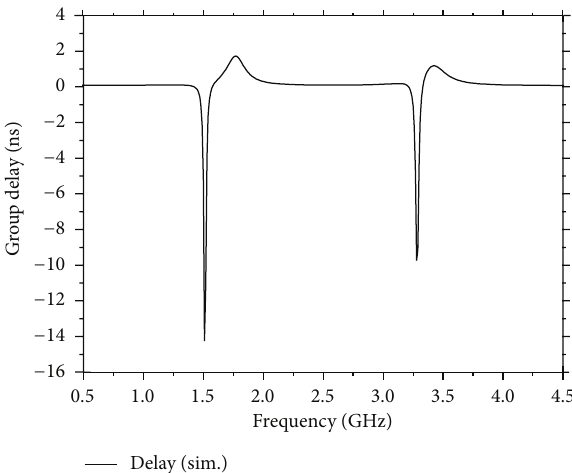
Figure 7: Group delay of the proposed cross-network working at 1.8 GHz and 3.5